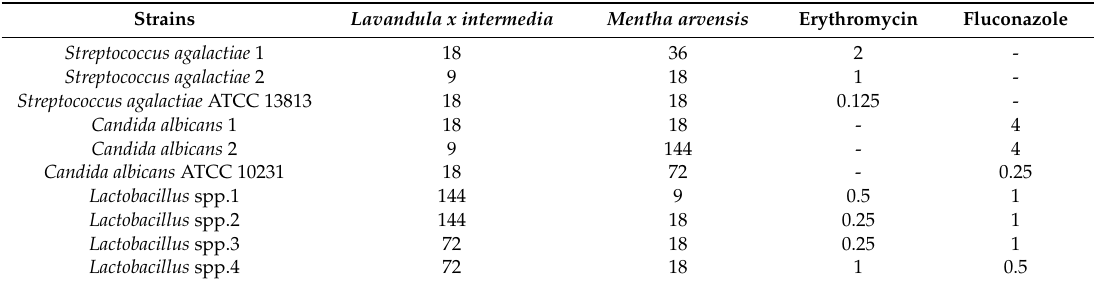
Table 2. Minimum inhibitory concentration (MIC) of EOs in comparison with the two reference antimicrobials (erythromycin and fluconazole). Data are expressed as µ g / mL. Strains Lavandula x intermedia Mentha arvensis